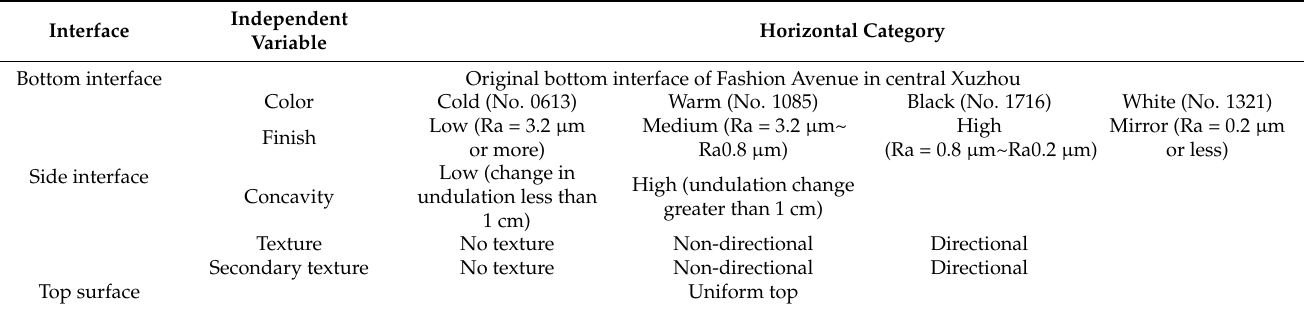
Table 3. Independent variables of experimental